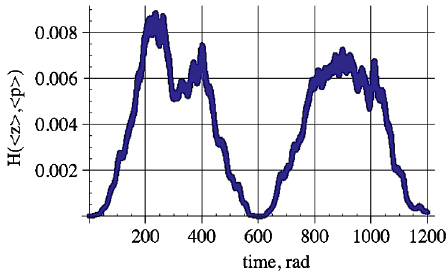
FIG. 2. Time dependence of the unperturbed Hamiltonian taken for the bunch-average coordinate and